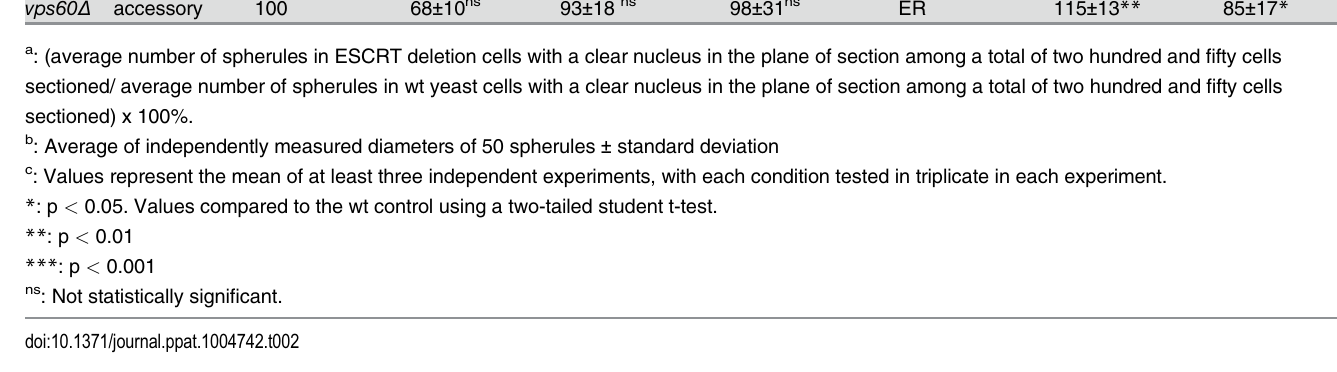
a : (average number of spherules in ESCRT deletion cells with a clear nucleus in the plane of section among a total of two hundred and fi fty cells sectioned/ average number of spherules in wt yeast cells with a clear nucleus in the plane of section among a total of two hundred and fi fty cells sectioned) x 100%. b : Average of independently measured diameters of 50 spherules ± standard deviation c : Values represent the mean of at least three independent experiments, with each condition tested in triplicate in each experiment. * : p < 0.05. Values compared to the wt control using a two-tailed student